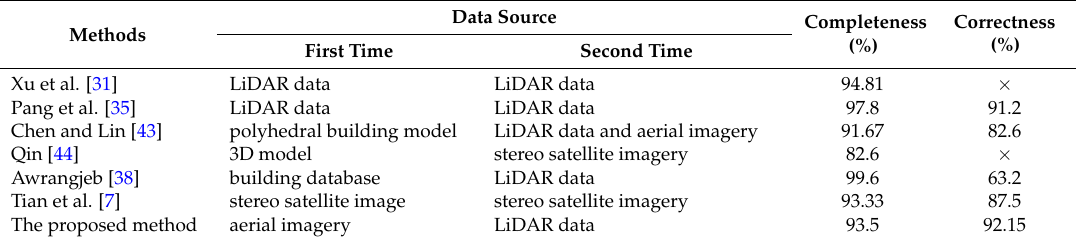
Table 3. Comparison results of Completeness and Correctness to relevant studies ( × means no relevant